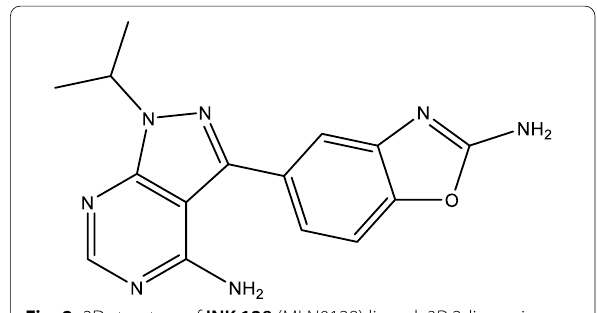
Fig. 8 2D structure of INK 128 (MLN0128) ligand. 2D 2dimension